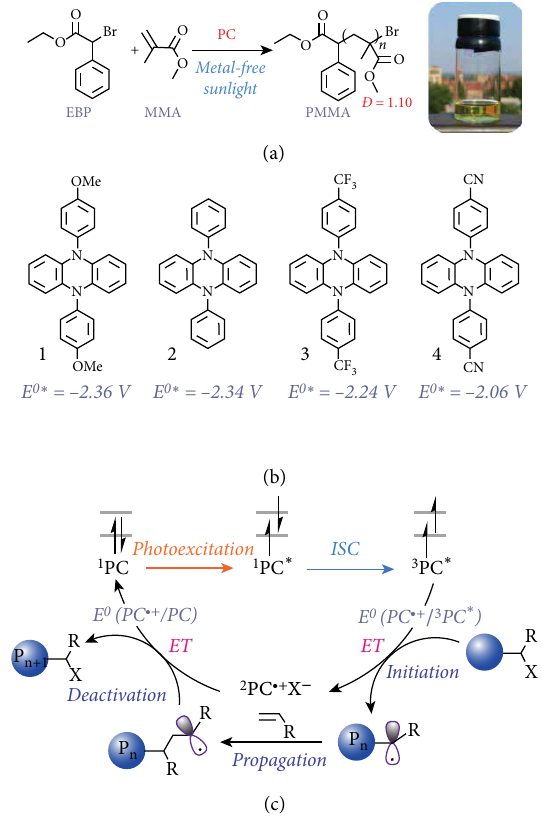
Figure 6: PC development for O-ATRP. (a) Polymerization of MMA to well-defined polymers by using photoredox O-ATRP driven by sunlight. (b) Structures of the diphenyl dihydrophenazine PCs 1 to 4 used in this study. (c) A proposed mechanism for ATRP mediated by a PC via photoexcitation to 1 PC , intersystem crossing (ISC) to the triplet state 3 PC , ET to form the radical cation doublet 2 PC •+ , and ∗ back ET to regenerate PC and reversibly terminate polymerization. ∗ (Adapted with permission from Ref.